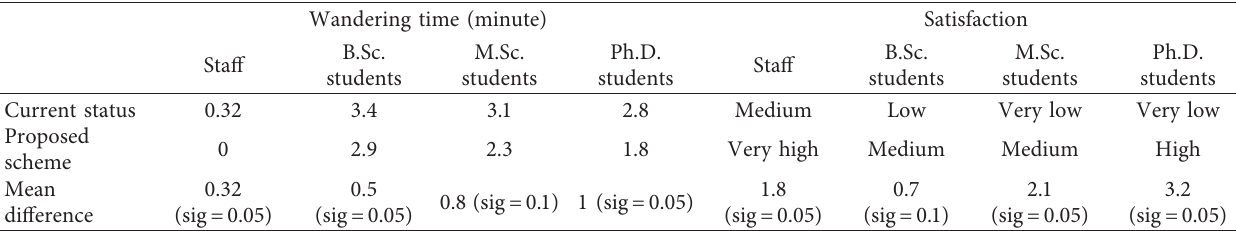
Table 15: Wandering time and satisfaction of students and